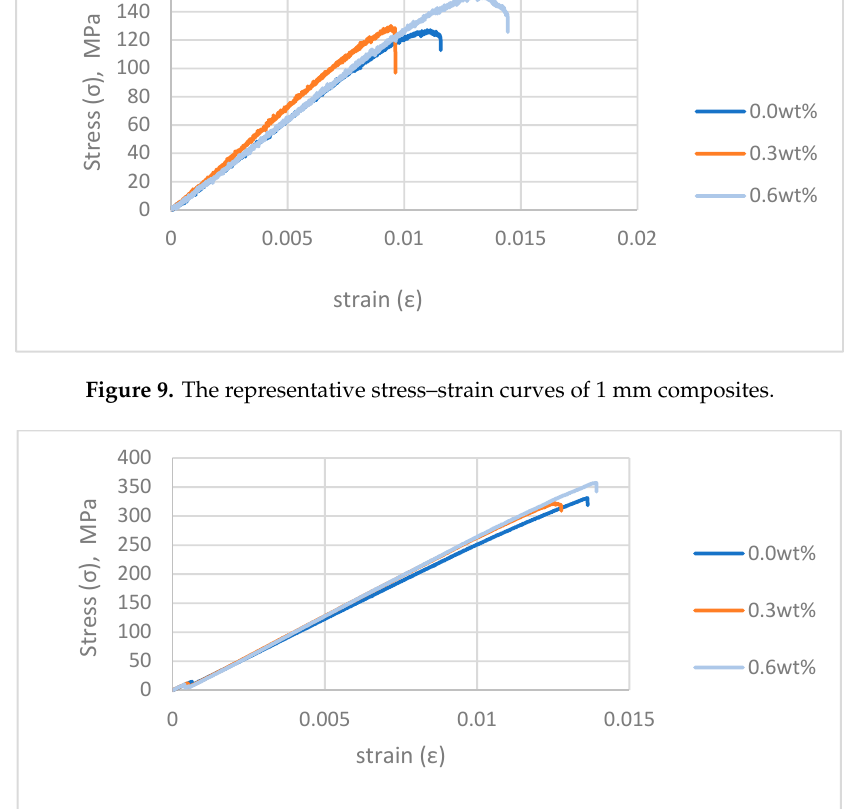
Figure 10. The representative stress–strain curves of 3 mm composites.